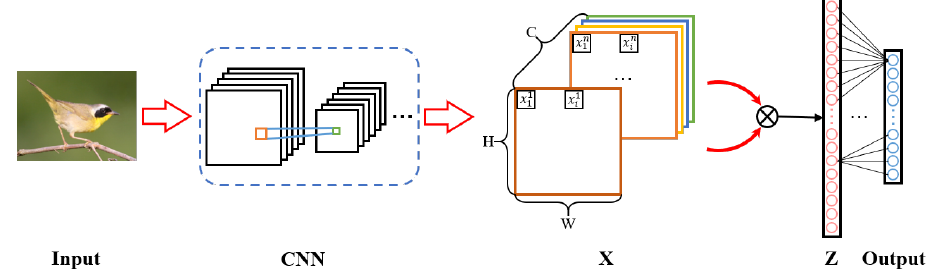
Figure 1. The architecture of Bilinear CNN. X is the high-order features extracted by CNN. Z is the full bilinear representation obtained by bilinear